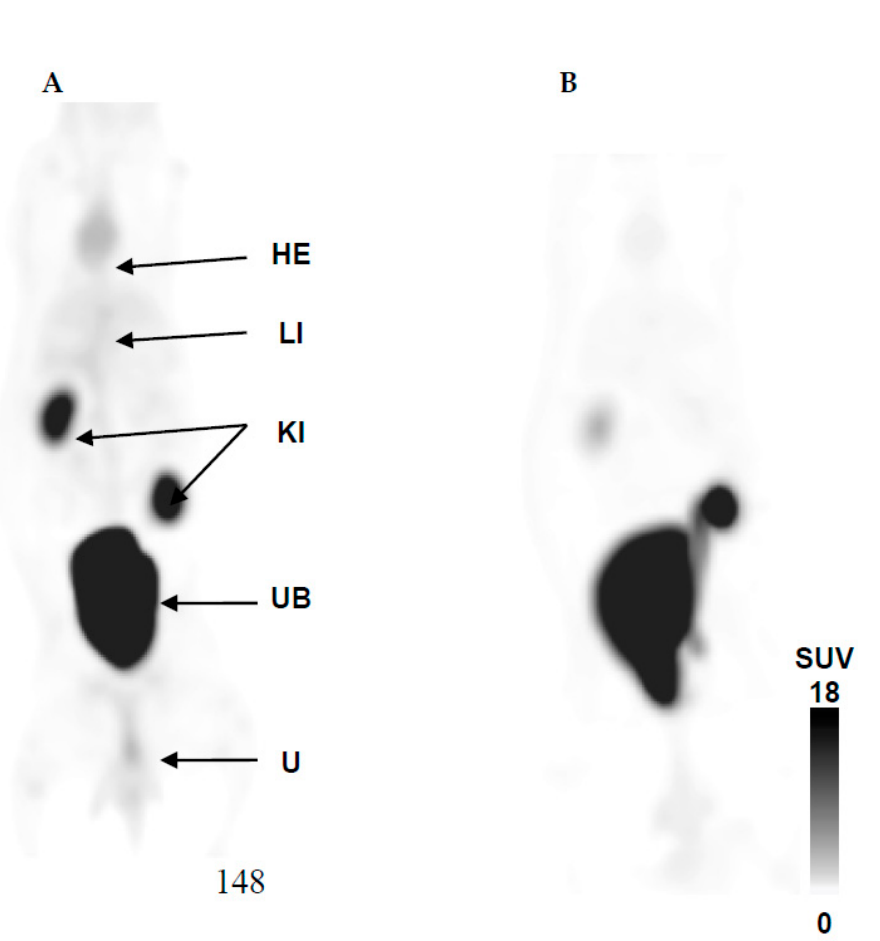
Figure 3. Healthy biodistribution of 68 Ga-DOTA-TBIA101 at ( A ) 5 min and ( B ) 60 min post-tracer injection. Maximum intensity projection (MIP) PET/CT images show the expected biodistribution in heart (HE), liver (LI), and strong excretion represented by activity in kidneys (KI), urinary bladder (UB), and urine.